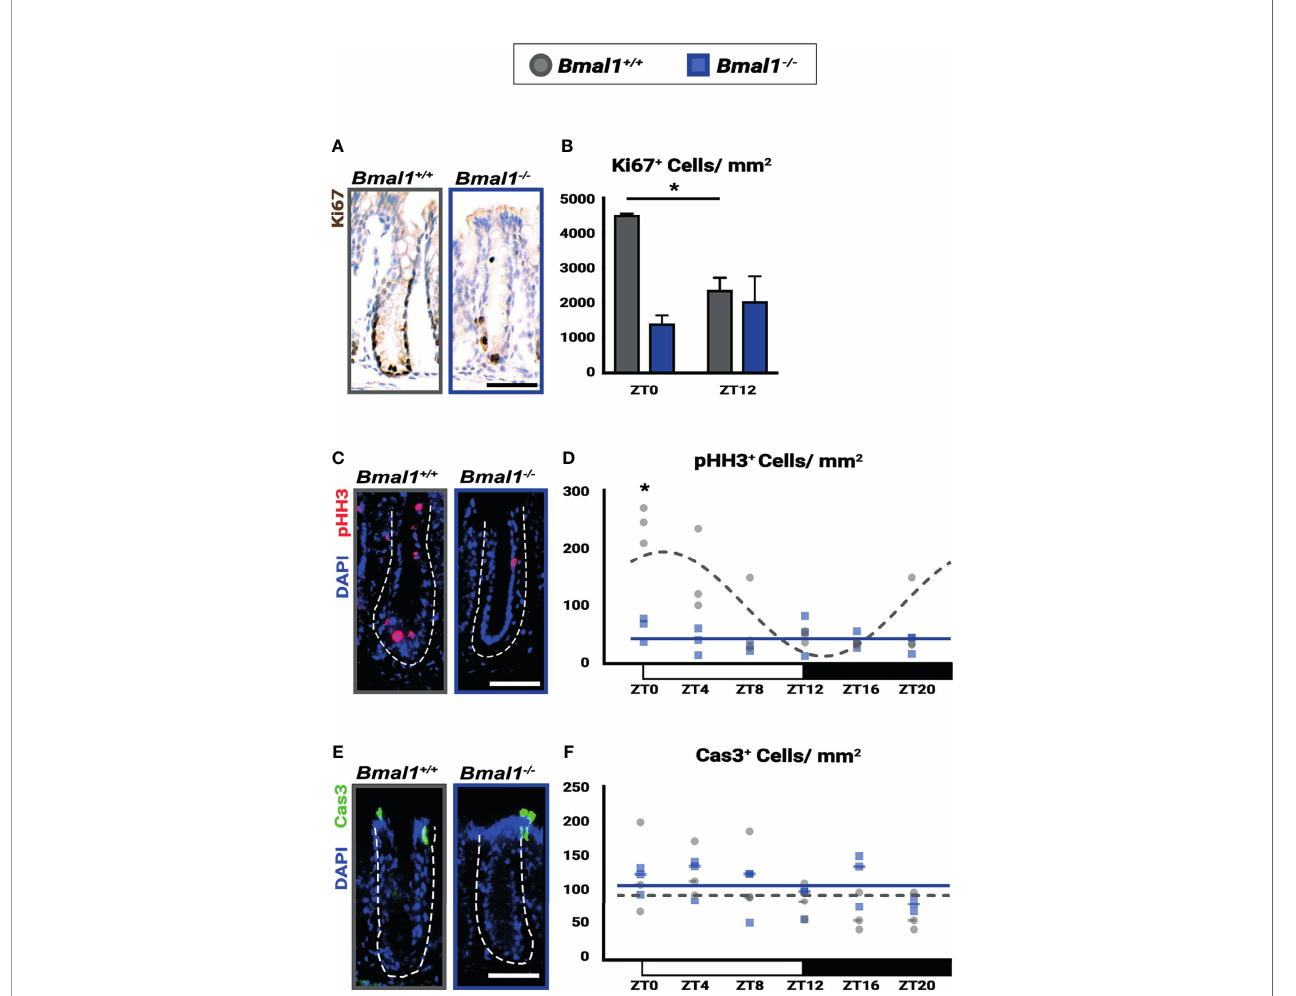
FIGURE 7 | Diurnal rhythms in regeneration are disrupted and decreased in Bmal1 -/- mutant mice. Bmal1 +/+ control and Bmal1 -/- mutant mice were collected after DSS treatment to induce colitis, and morphologically normal crypts were examined. (A, B) Proliferation (Ki67 shown in brown) is increased in Bmal1 +/+ control compared to the Bmal1 -/- mutant at ZT0, and is also signi fi cantly increased at ZT0 compared to ZT12 in the Bmal1 +/+ control (Two-way ANOVA, *p=0.0096, F (1,8) =11.43; Tukey ’ s test, ZT0 Bmal1 +/+ - Bmal1 -/- *p=0.0031, ZT0, 12 Bmal1 +/+ *p=0.0253). In contrast, proliferation is decreased and does not signi fi cantly change between ZT0 and ZT12 in Bmal1 mutants. (C, D) Mitosis (marked by phosphorylated histone-H3, pHH3 in red) is increased and rhythmic in Bmal1 +/+ control mice with colitis while decreased and arrhythmic in Bmal1 -/- mutants (Two-way ANOVA, *p=0.0021, F (5,24) =5.264; Tukey ’ s test, ZT0 Bmal1 +/+ - Bmal1 -/- *p=0.0003; Chronos-Fit, Bmal1 +/+ *p=0.0011). (E, F) Apoptosis (marked by cleaved Caspase-3, Cas3 in green) does not exhibit signi fi cant differences between either Bmal1 +/+ control and Bmal1 -/- mutant colons and is not expressed rhythmically (Two-way ANOVA, p=0.5329, F (5, 22) =0.8444). (All error bars represent SEM. Dashed lines indicate crypt. Scale bar=